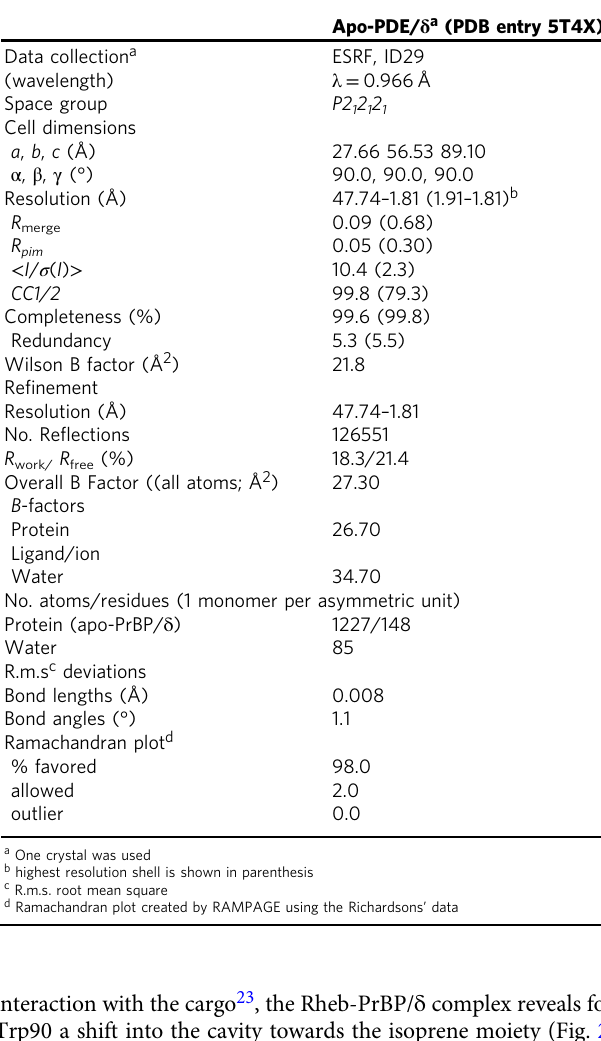
Table 1 Data collection and re fi nement